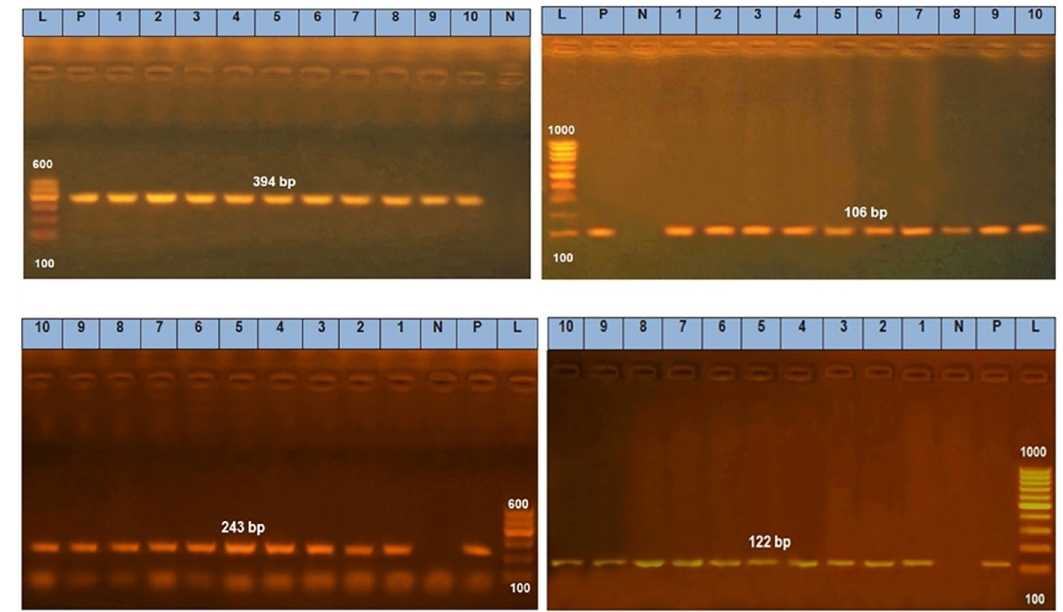
Fig 13. Gel electrophoresis of Candida virulence genes, Secreted Aspartic Protease gene (SAP4) was detected at 394 bp, RAS1 was detected at 106 bp, Hyphal-Associated Adhesin (HYR1) gene was detected at 243 bp and agglutinin-like sequence gene (ALS3) was detected at 122